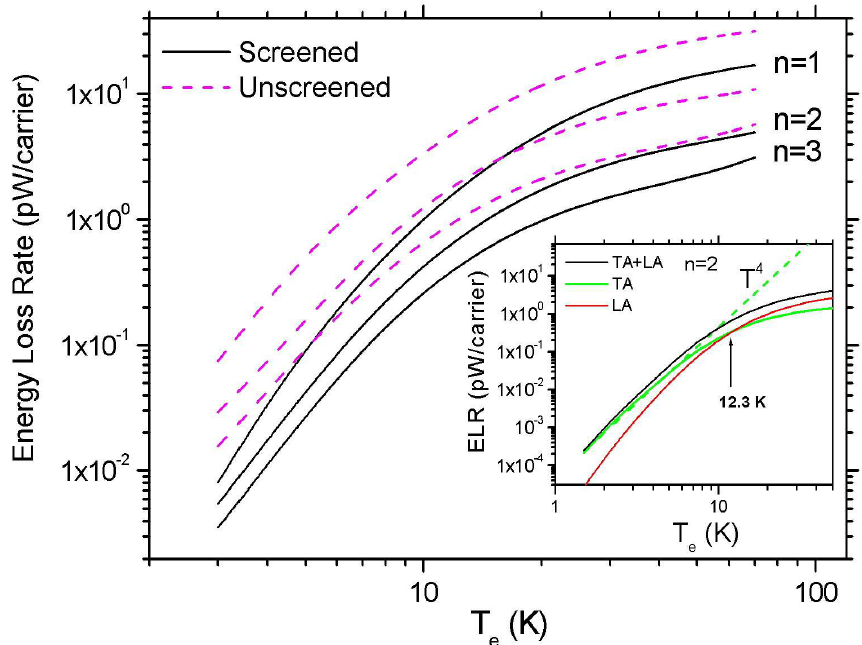
Figure 5. The calculated ELR peaks at n = 1,2, and 3 as a function of T e . The solid lines are the results when screening is taken into account, and the dashed magenta curves show ELR when screening is ignored. The inset shows the contributions to ELR when n = 2 arising from electron coupling with LA (red solid line) and TA phonons (green solid line). At low temperatures, the total ELR follows a T 4 e law (dashed green line). ( n s = 10 16 m − 2 and γ = 2 meV/T 1/2